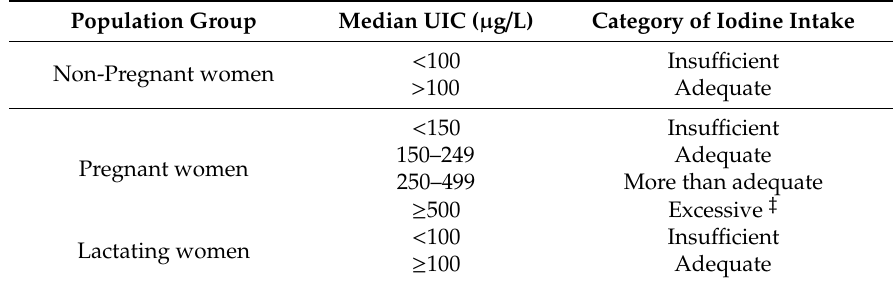
Table 1. Median urinary iodine concentration (UIC) categories in non-pregnant, pregnant and lactating